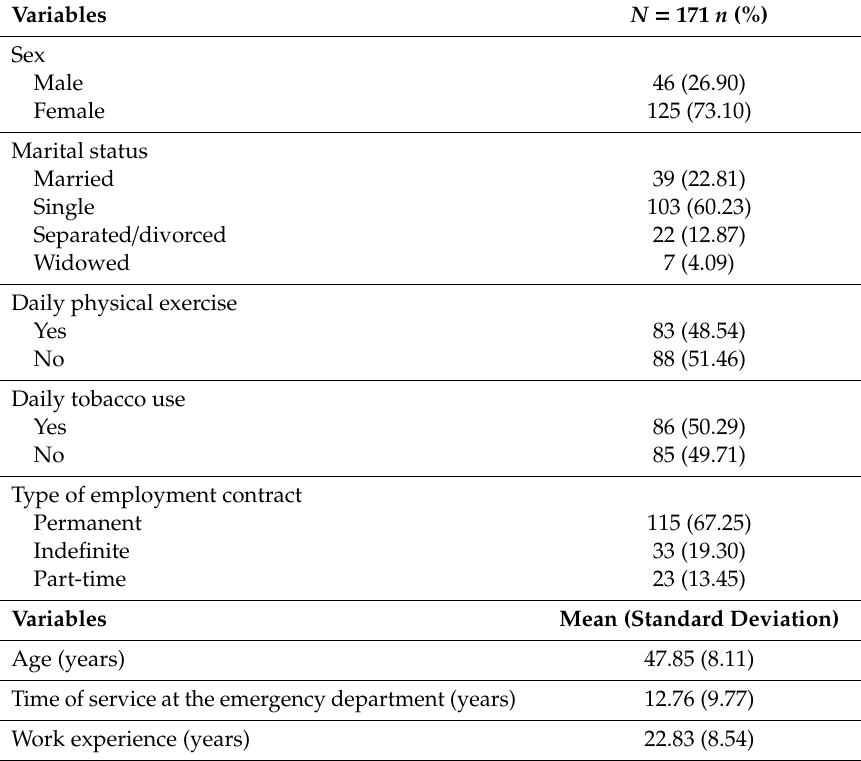
Table 1. Sociodemographic and occupational characteristics of the